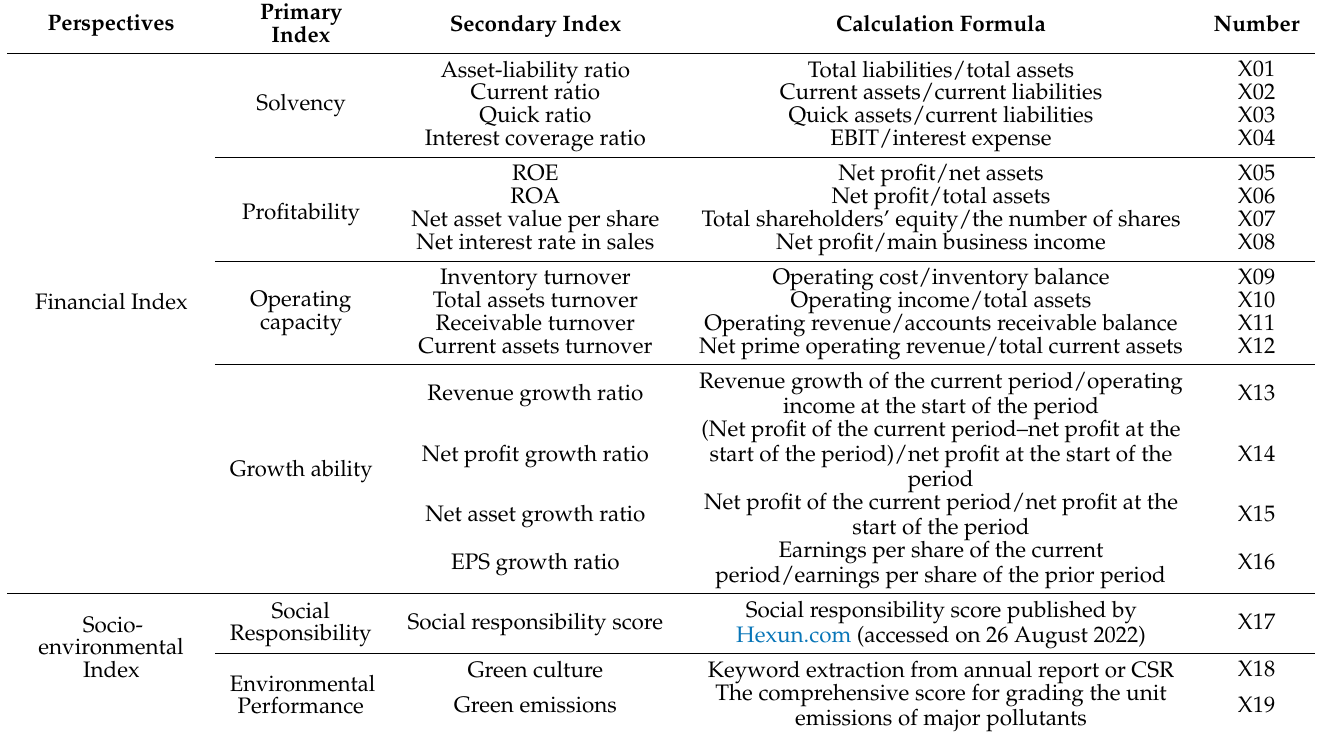
Table 1. Green credit risk evaluation index